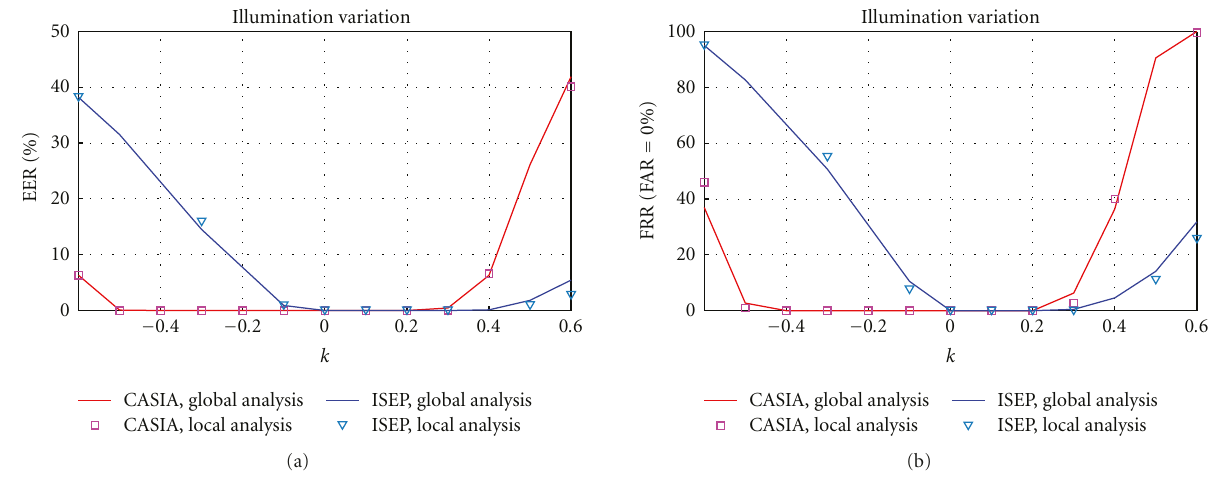
Figure 15: (a) EER and (b) FRR (FAR = 0%) as a function of the illumination, measured on CASIA and ISEP